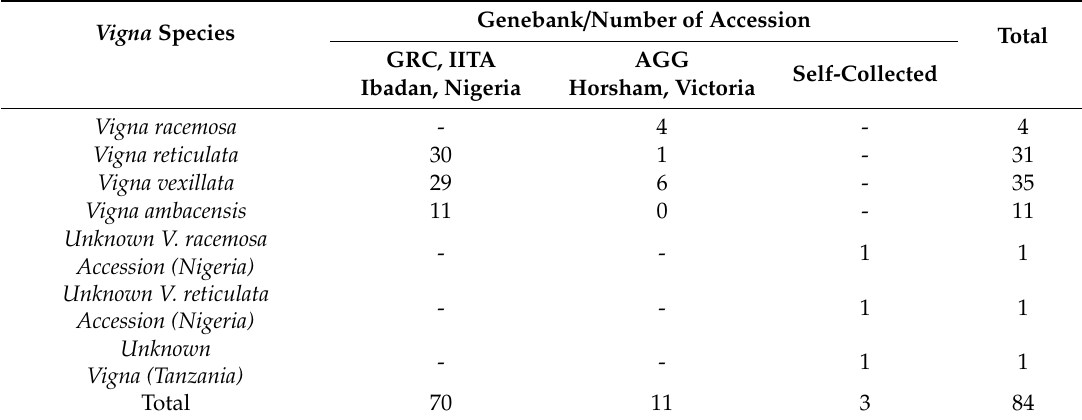
Table 1. Wild Vigna species collected from the gene banks /